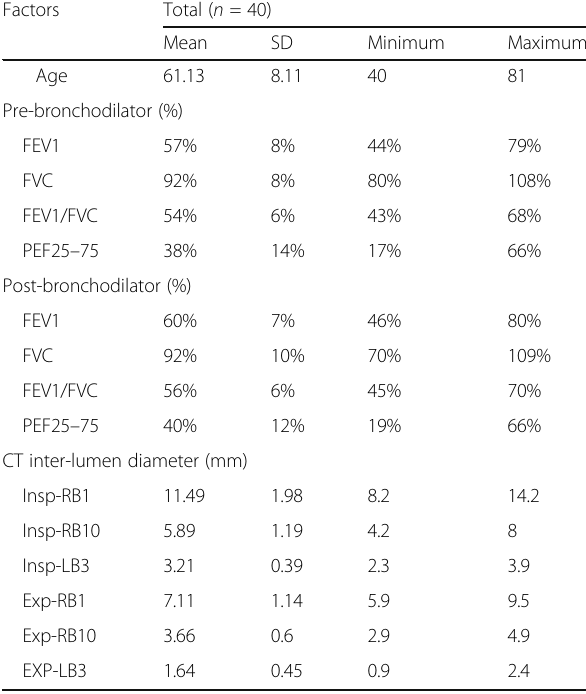
Table 1 Patient ’ s characteristics